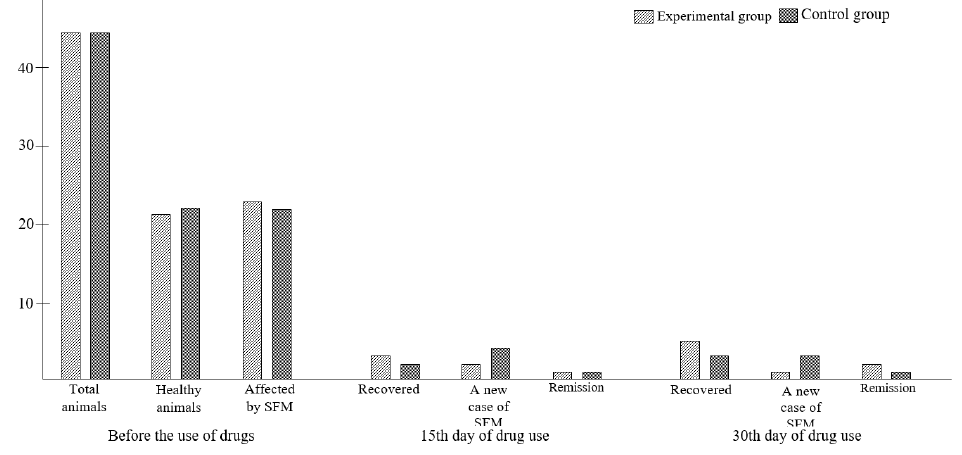
Fig. 1. Dynamics of cases of subclinical mastitis in cows, M ± m, n = 45